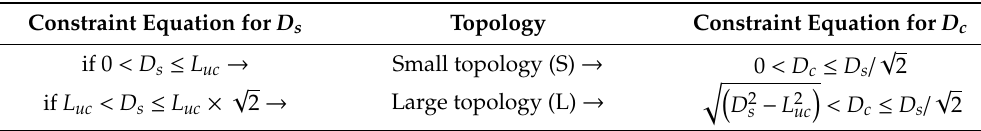
Figure 4. Schematic utilized to determine the equation constraint that the diameter of cylinders D c must satisfy in the case of Topology (L). Table 1. Constraint equations that the diameter of the sphere D s and the cylinders D c must satisfy to guarantee the coherence of the sca ff old